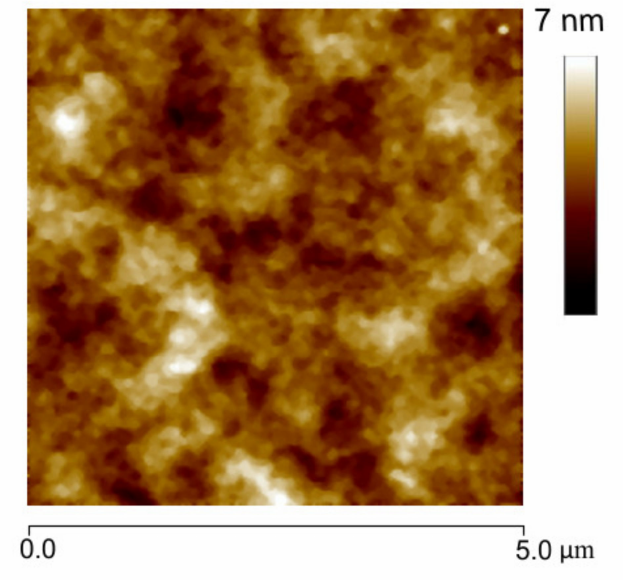
Figure 7. Morphological characteristics tapping image of PDMS film.